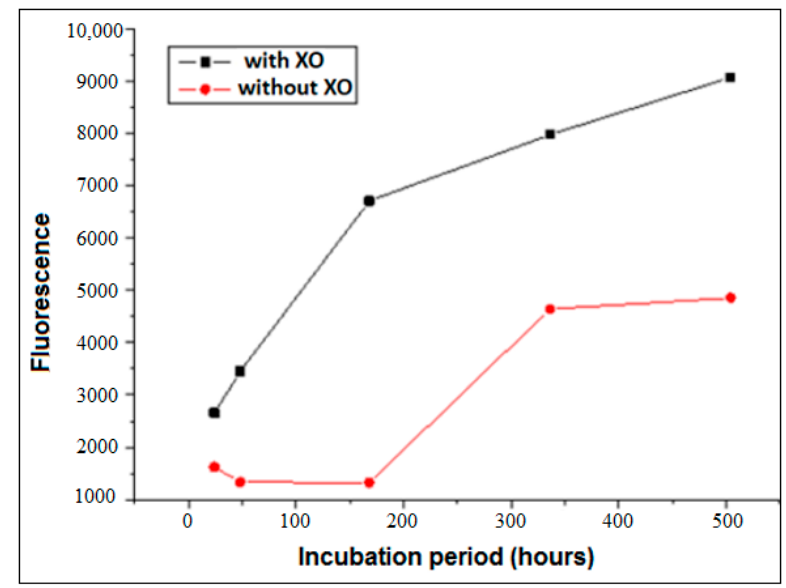
Figure 2. Formation of AGEs using glucose (37 °C) in the presence or absence of xanthine oxidase (XO) in pure phosphate buffer (pH = 6.6) during different incubation times (24 h, 48 h, 1 week, 2 weeks, 3 weeks).